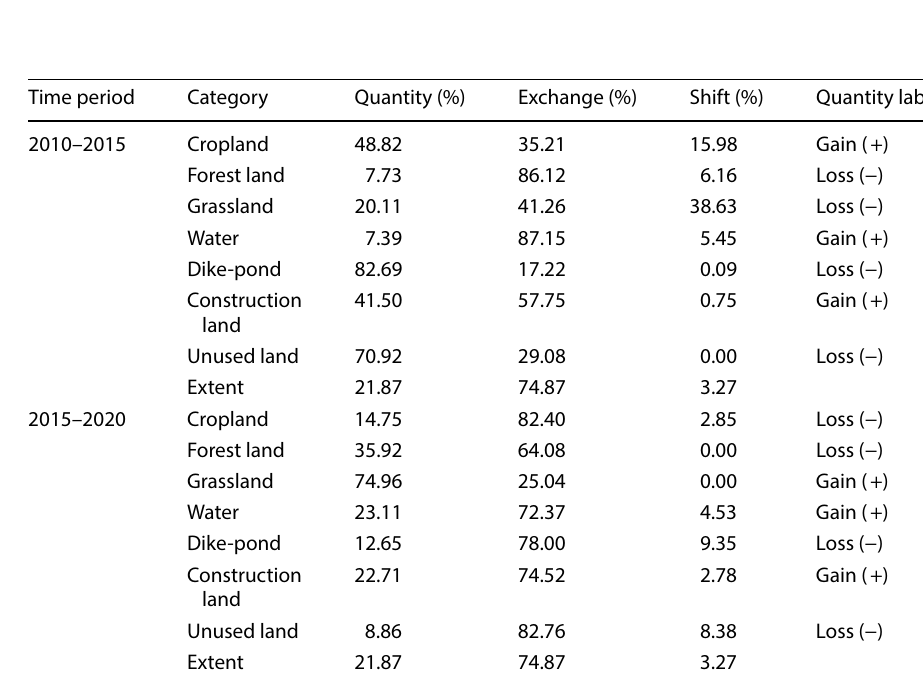
Fig. 9 Transition level of the dike-pond from 2010 to 2020